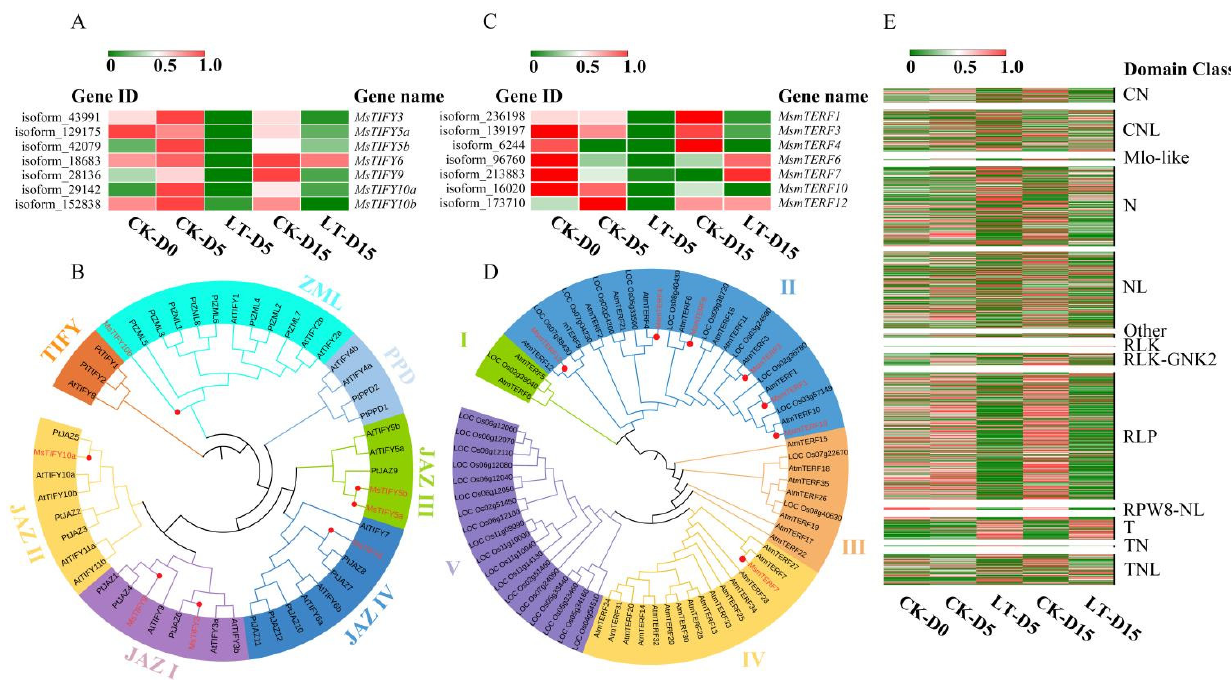
Figure 5. Analysis of TIFY family genes, mTERF family genes, and R-genes in M. sinostellata . ( A ) The expression profile of MsTIFY gene family in leaves of M. sinostellata under light deficiency and untreated conditions. Two pairs of duplicated paralogs are marked by lowercase letters. ( B ) Phylogenetic tree of TIFY protein sequences from M. sinostellata , Arabidopsis thaliana and Populus trichocarpa, which was constructed using the NJ (neighbor-joining) method with 1000 bootstrap replications. ( C ) Expression profiles of MsmTERFs under light deficiency and normal light conditions. ( D ) Phylogenetic tree of mTERF protein sequences from M. sinostellata , Arabidopsis thaliana, and Zea mays, which was constructed using the NJ method with 1000 bootstrap replications. ( E ) Expression patterns of 13 classification of R-genes in M. sinostellata under light deficiency and normal light